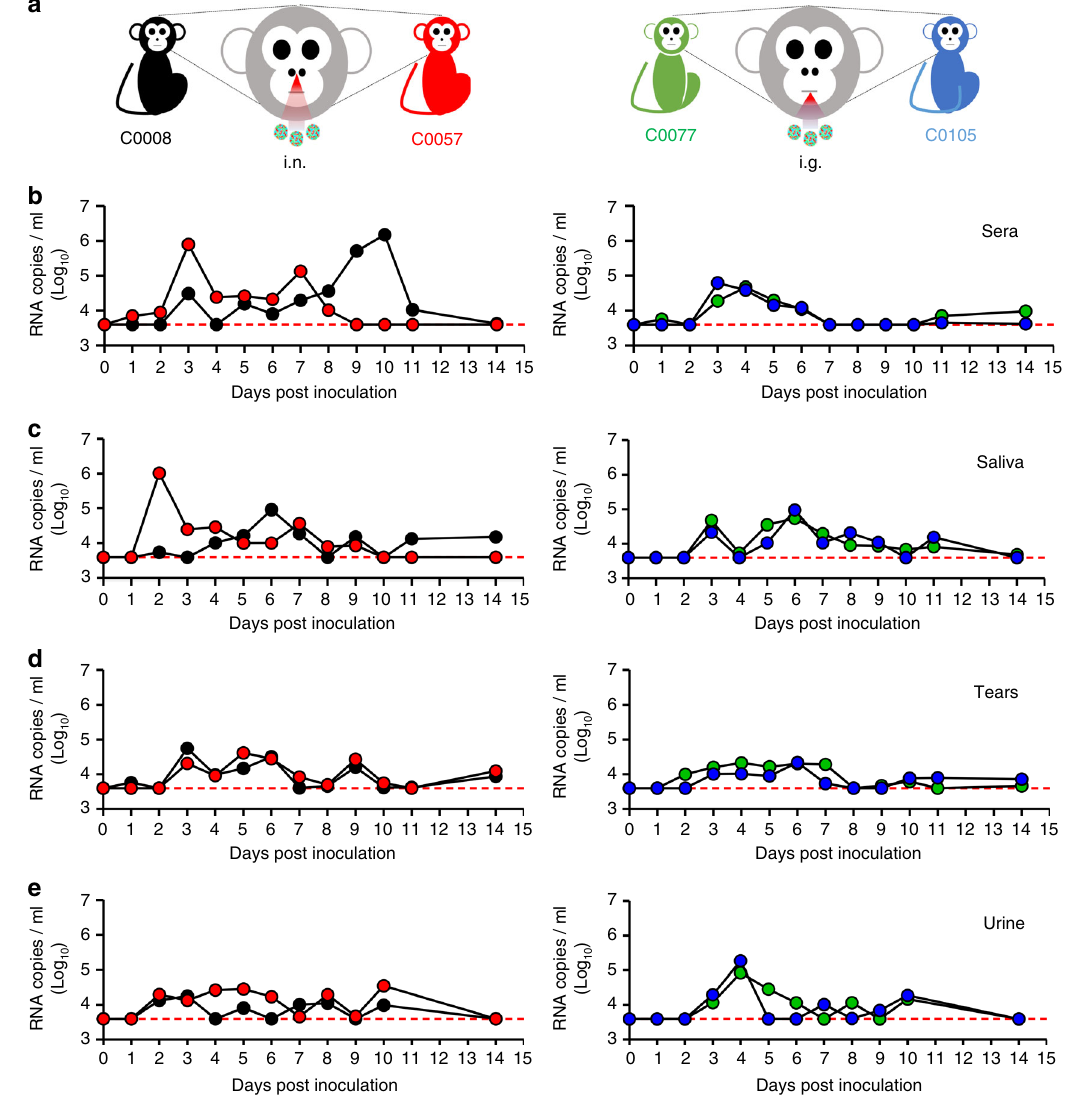
Fig. 4 Characterization of ZIKV infection in cynomolgus monkeys following i.n. and i.g. inoculation. a Two adult cynomolgus monkeys received i.n. inoculation with 10 5 PFU of ZIKV, and the other two animals received i.g. inoculation. Viral RNA loads in b sera, c saliva, d tears, and e urine were determined, respectively, at the indicated time points. The dotted lines indicate the limit